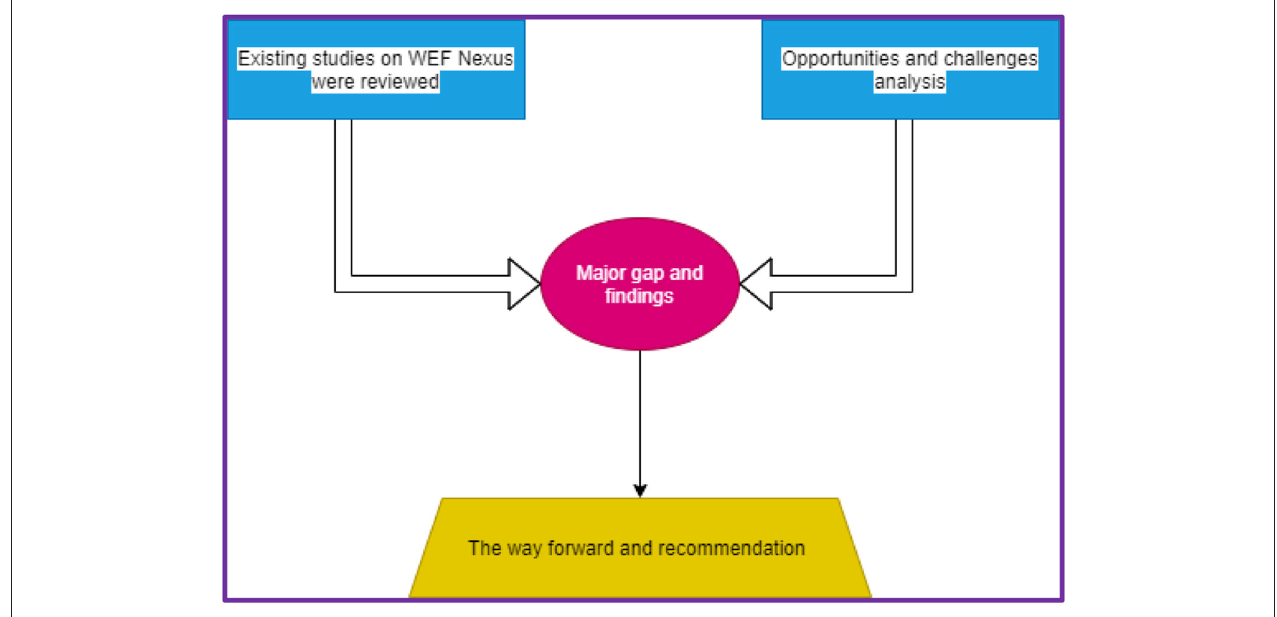
FIGURE 1 | Schematic flow chart of the process.